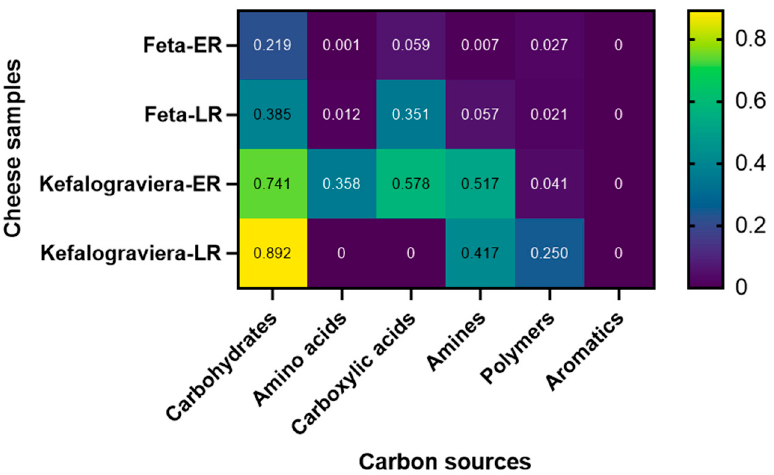
Figure 6. Heat map of the fermentation of different groups of carbon sources by the microbial community of each cheese sample. Each square of the heat map displays the average absorbance value estimated from all carbon sources of each group and all replicates (three technical × two biological). Color scale indicates the extent of carbon source utilization (dark purple to yellow, low to high).